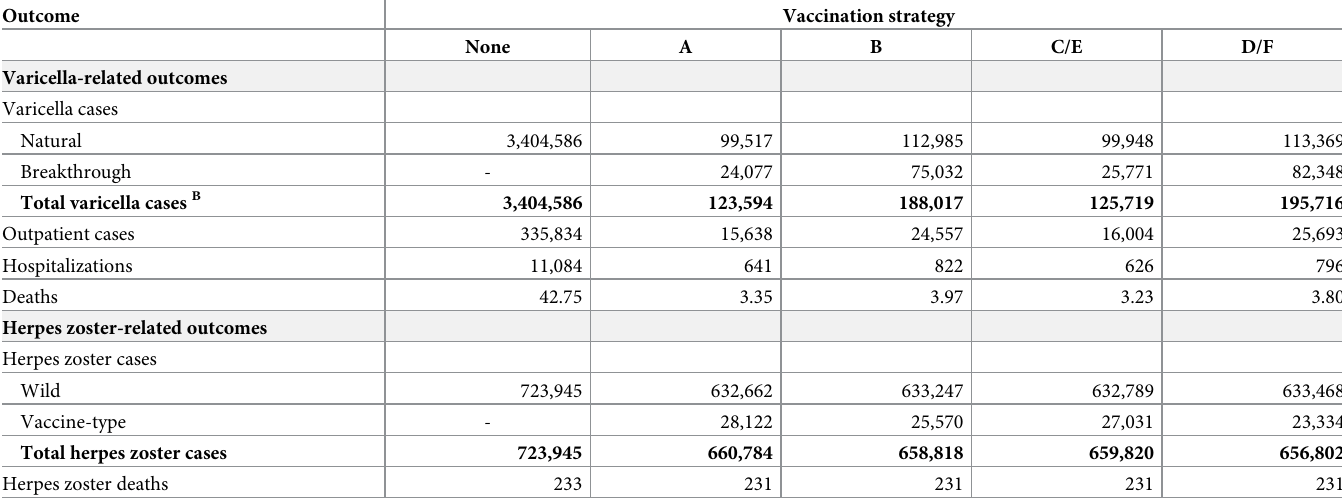
A Clinical outcomes with strategies E and F were the same as with strategies C and D, respectively. B Total varicella cases include those not seeking medical